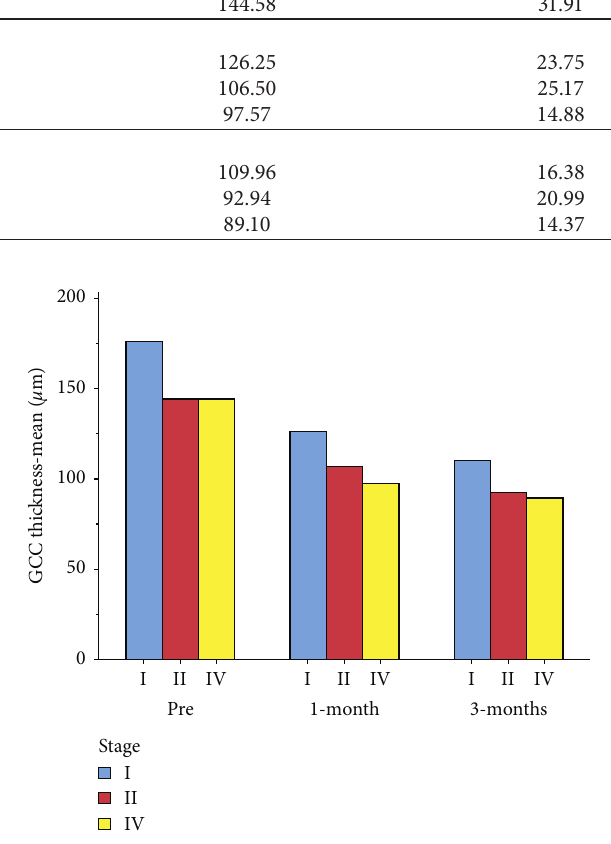
Figure 5: Mean preoperative and postoperative GCC thickness values in the three groups. Table 5: Mean preoperative and postoperative GCC thickness of the perifoveal quadrants of three